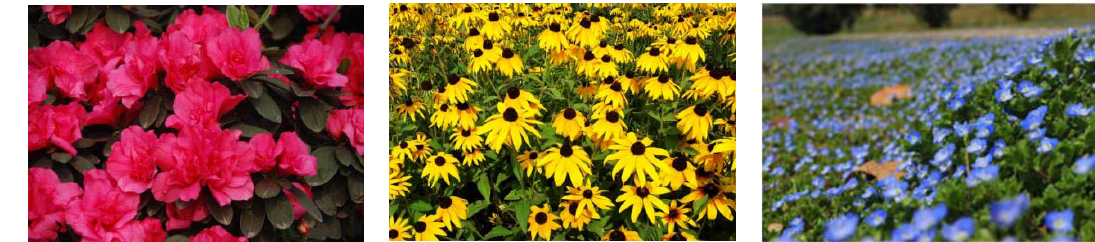
Figure 8. Landscape configuration orientation color map.